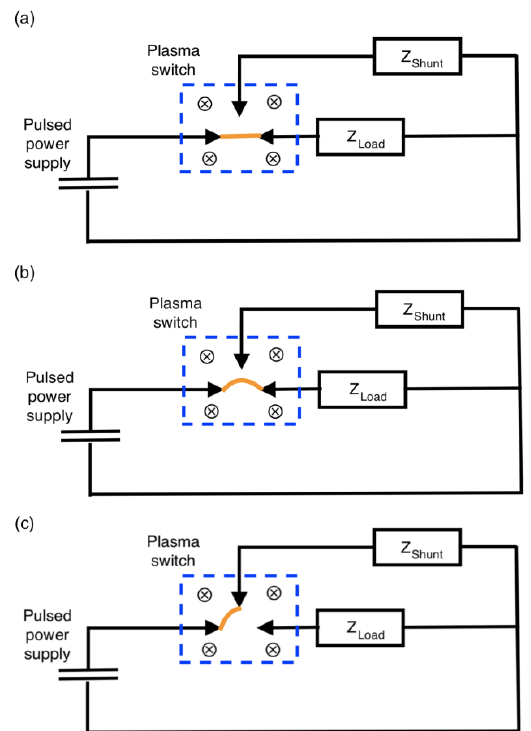
Figure 2. Schematic of switch operation. ( a ) Laser-induced breakdown of an arc between the supply and load occurs, ( b ) the external magnetic field increasingly deflects the arc, and ( c ) the arc begins preferentially conducting a current through the shunt.